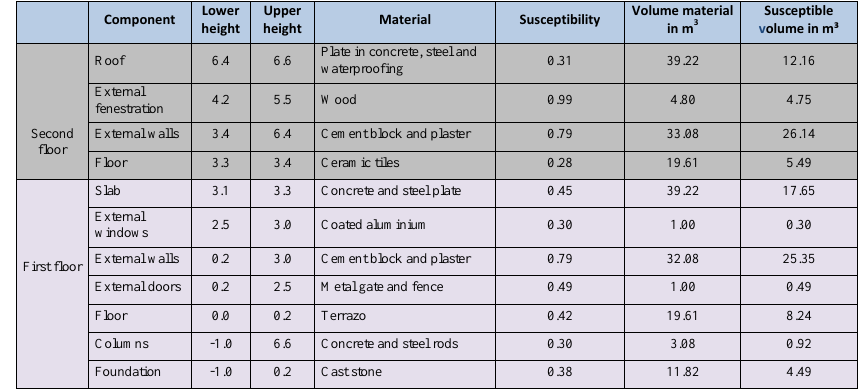
Table 3: Example of information collected for the analysis of susceptibility - Building ‘2221123’ Table 3. Example of information collected for the analysis of susceptibility – building “2221123”.